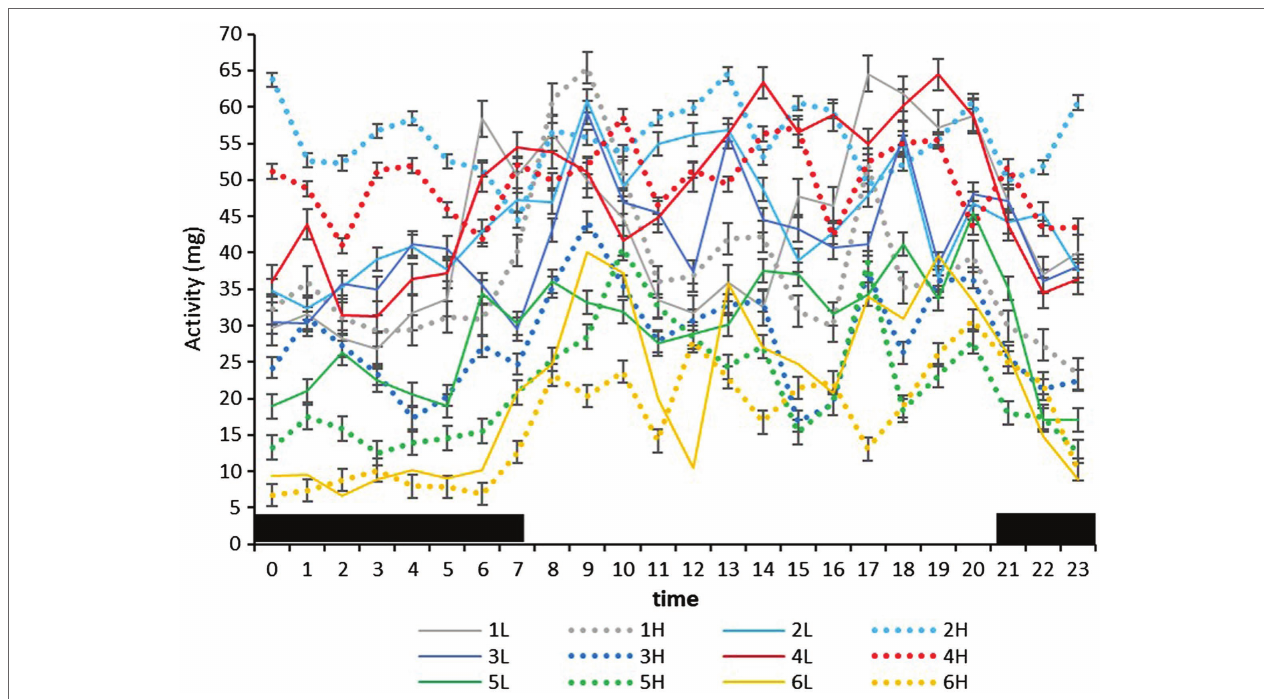
FIGURE 4 | Mean (±SEM) activity (standard acceleration of gravity, g ) of six cows measured by subcutaneous bio-loggers on 5 days of grazing at 1.5 LSUs/ha (low density, L) followed by 5 days of grazing at a density of 128 LSUs/ha (high density, H). Black areas indicate night (22:00–06:00